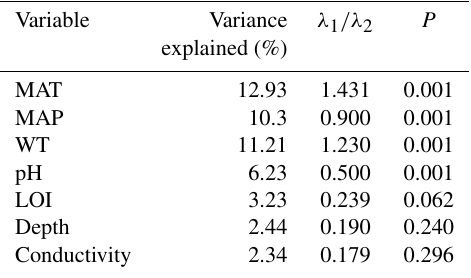
Table 3. Results of detrended canonical correspondence analysis (DCCA) using single constraining variables. MAT: mean annual temperature; WT: water temperature; MAP: mean annual precipi- tation; LOI: loss on